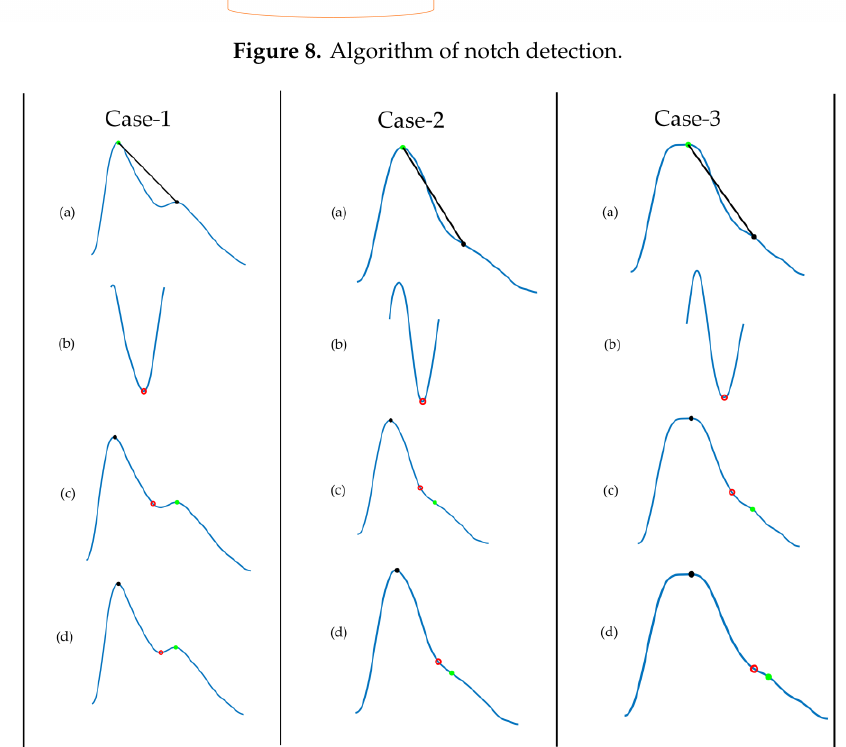
Figure 9. Demonstration of dicrotic notch detection for different age groups: Case 1 (26 years), 2 (45